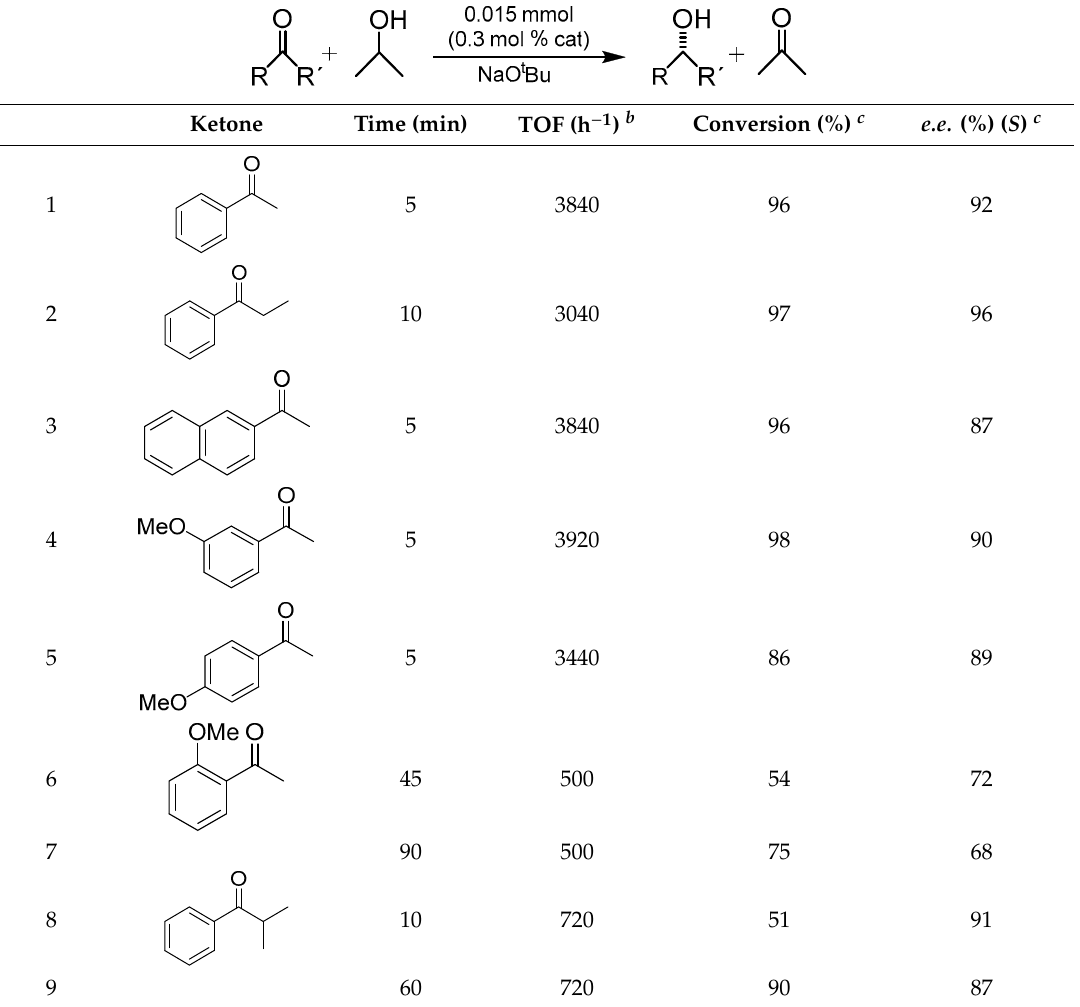
Table 3. Transfer Hydrogenation of Ketones Catalyzed by Complex [RuCl 2 {PPh 2 (OEt)}(Ph-pybox)] ( 2c ) under Optimized Conditions a